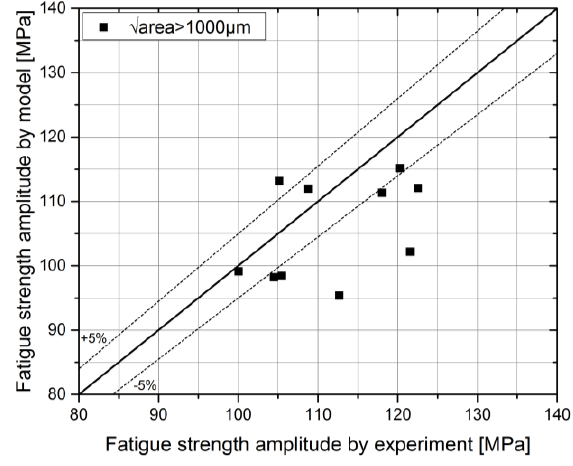
Figure 10. Comparison of fatigue strength amplitude by experiments to model by De Kazinczy [39].